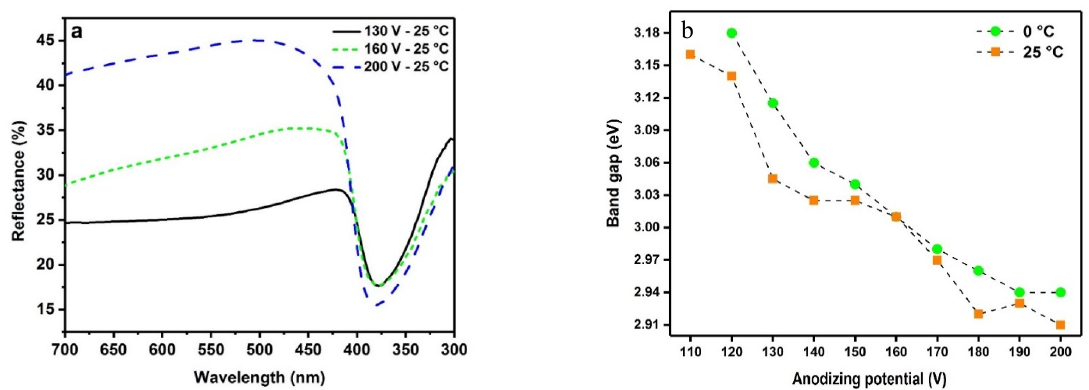
Figure 6. UV–Vis spectra of PEO TiO 2 obtained at 25 °C and 130, 160 and 200 V ( a ); band gap energy as a function of processing potential at 0 °C and 25 °C ( b ).